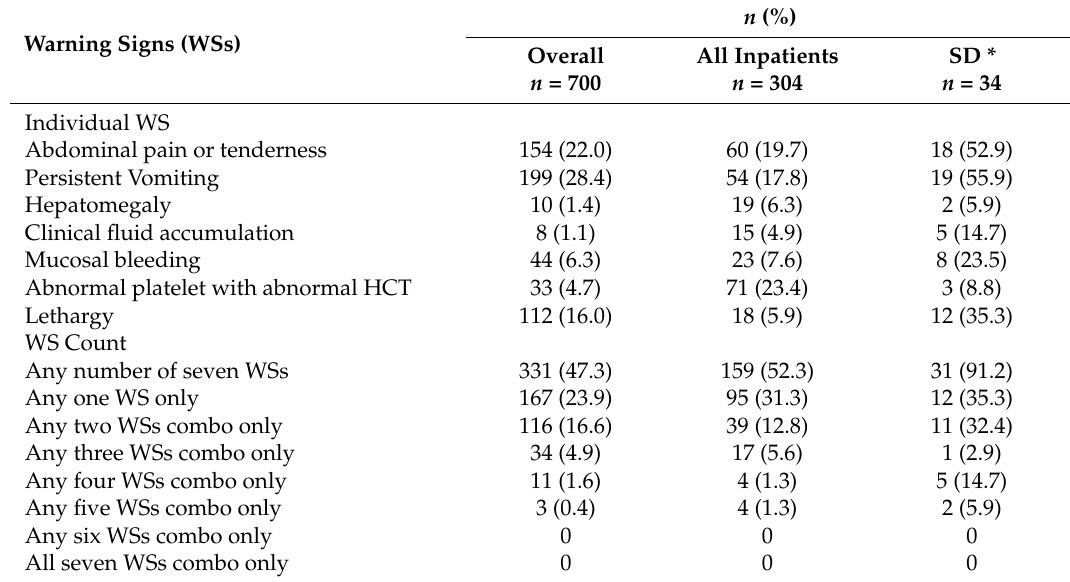
Table 4. Prevalence of warning signs at